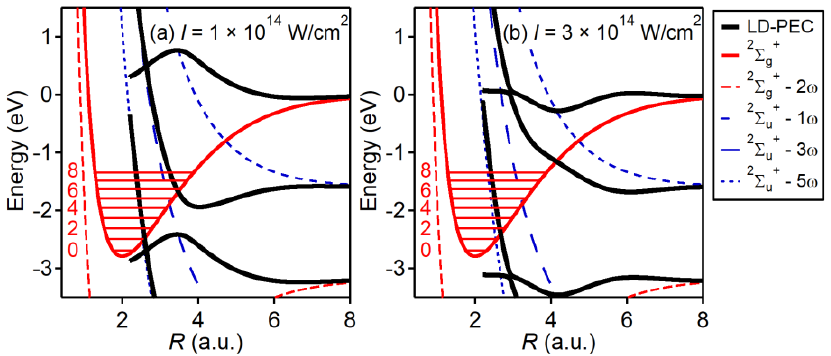
Fig. 1. The LD-PECs of D 2+ interacting with the near-IR (780 nm) laser field at the two different laser field intensities, (a) 1 × 10 14 W/cm 2 and (b) 3 × 10 14 W/cm 2 , as a function of the internuclear distance R . Red solid curve: the potential energy curve (PEC) of the ground 2  g+ state. Black curves: LD-PECs. Broken curves: PECs of 2  g+ shifted in energy by -2ħ  (red) and 2  u+ shifted in energy by –3ħ  , and –5ħ  (blue). The one-photon crossing point between 2  g+ and 2  u+ –ħ  is located around R = 4.7